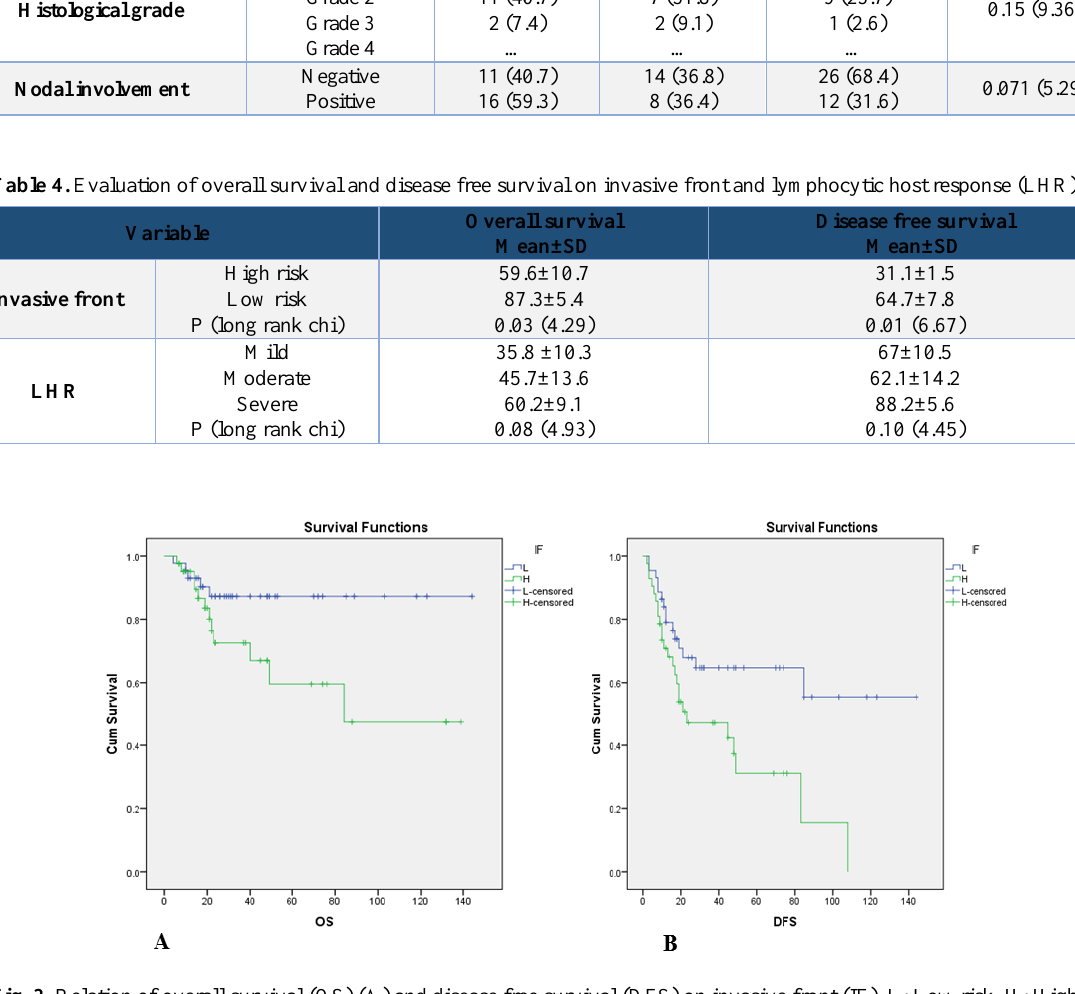
Fig. 3. Relation of overall survival (OS) (A) and disease free survival (DFS) on invasive front (IF), L: Low risk, H: High